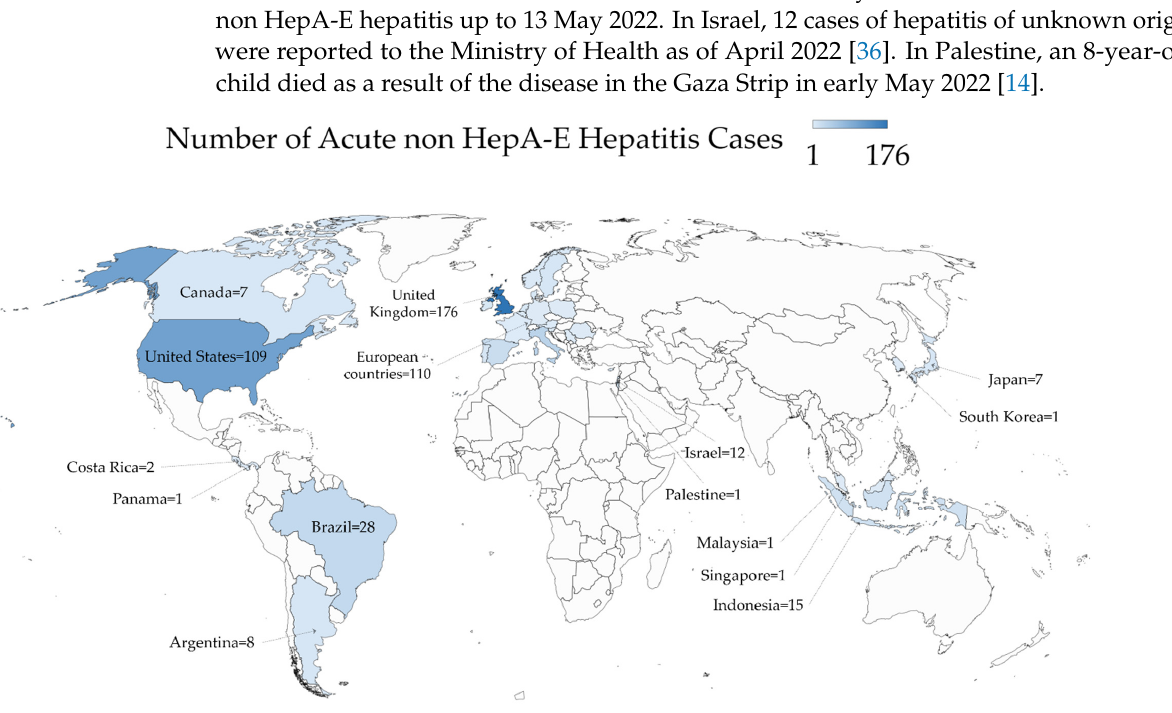
Figure 1. The global geographic distribution of acute non HepA ‐ E hepatitis as of 13 May 2022. The map was generated in Microsoft Excel, powered by Bing, © GeoNames, Microsoft, Navinfo, TomTom, Wikipedia. We are neutral with regard to jurisdictional claims in this